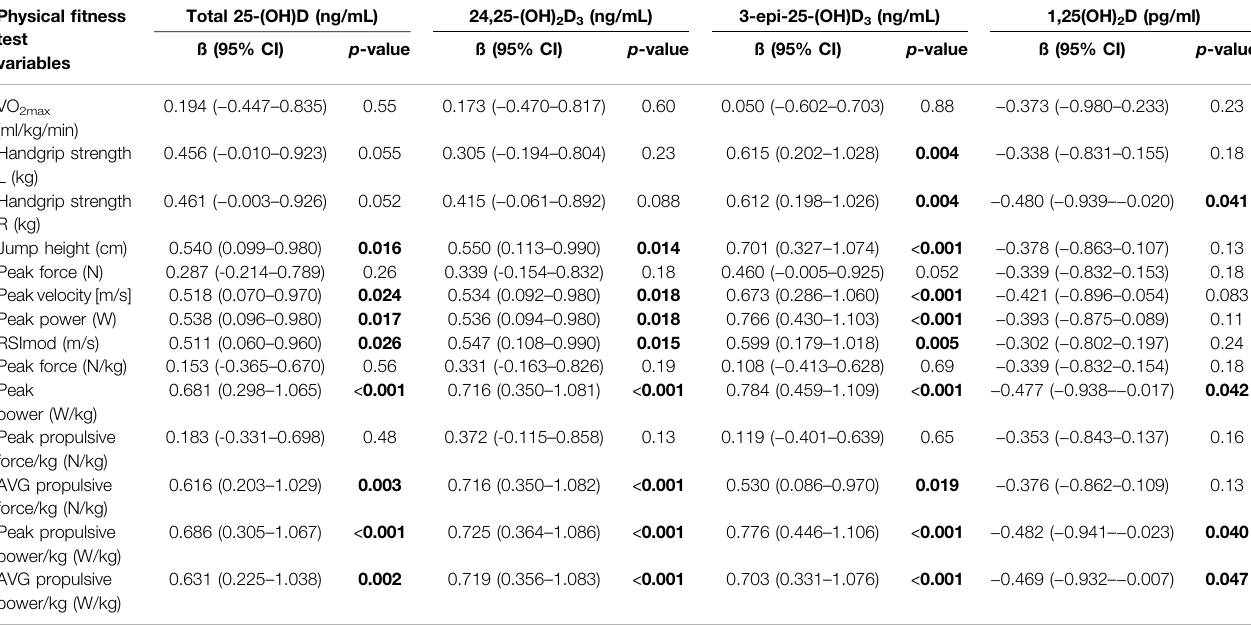
TABLE 2 | Association of athletic performance with vitamin D metabolites by multiple regression analyses* in indoor players ( n = 16). Physical fi tness test